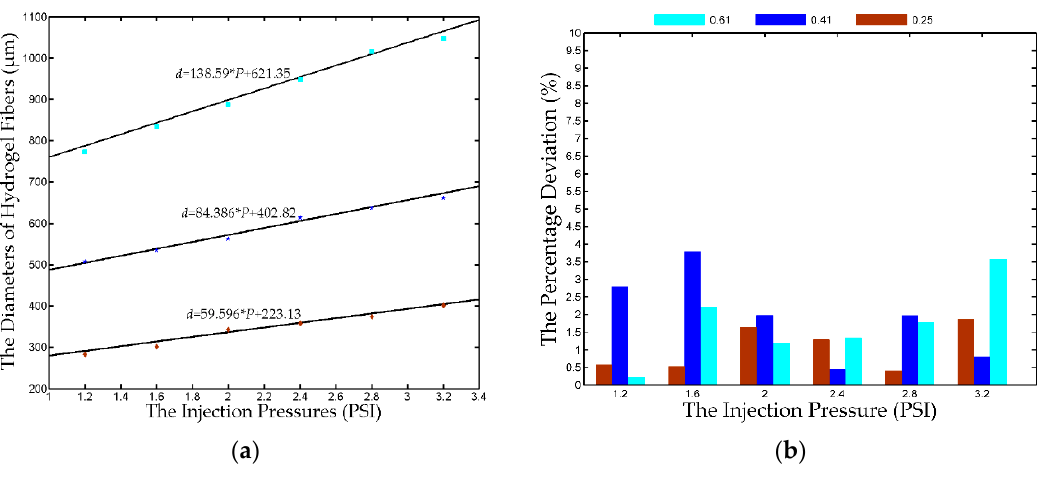
Figure 4. The comparison of the predicted and measured diameters. ( a ) The solid lines are drawn based on the identified linear models and the colored markers represent the experimental results; ( b ) the percentage deviation between the predicted and measured diameters. The legends with different colors represent the different inner diameters of the nozzles utilized in the fabrication of hydrogel fibers, respectively.